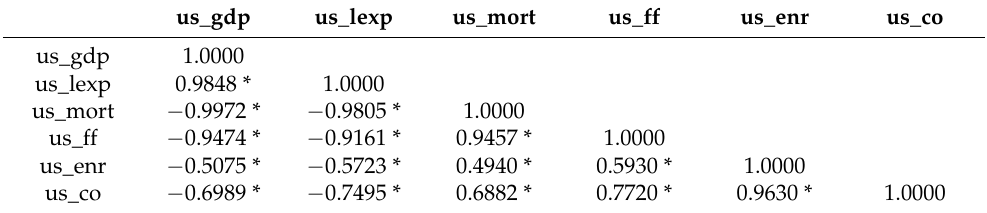
Table 3. Correlation matrix of the U.S..